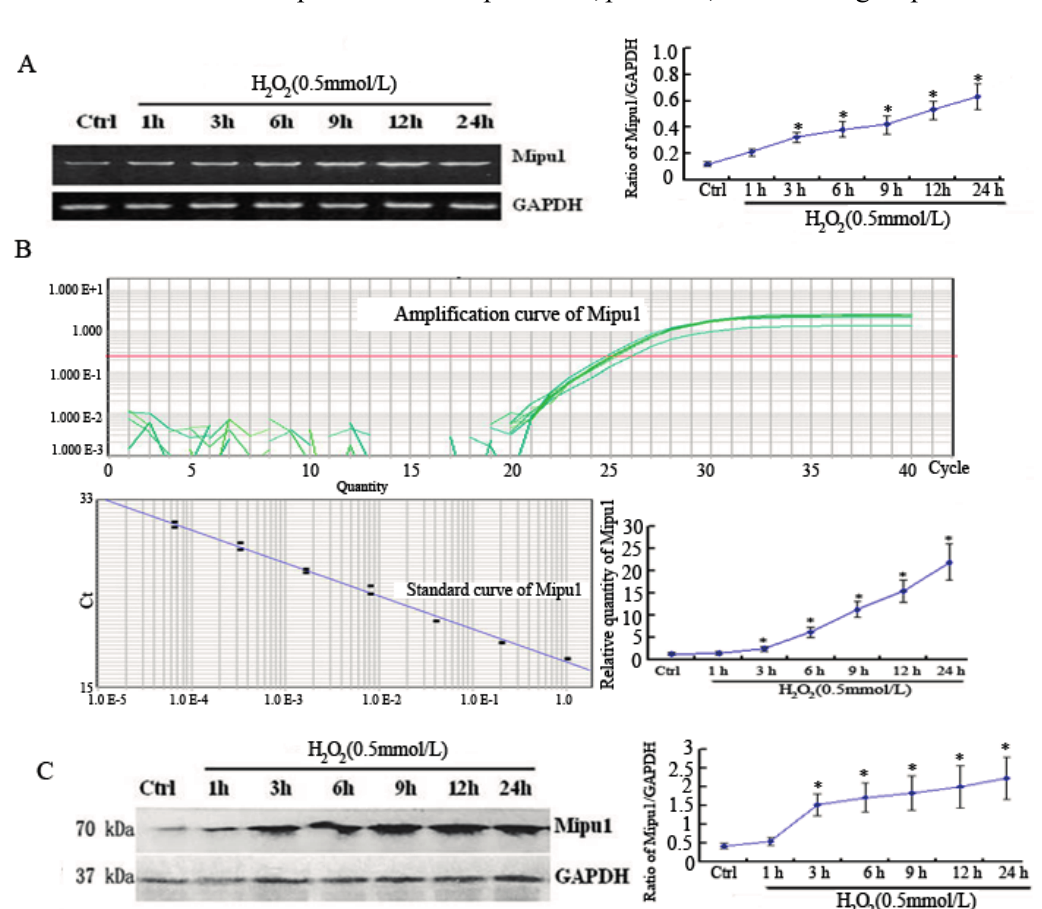
Figure 1. Expression of Mipu1 over H 2 O 2 -stimulated H9c2 myogenic cells over 24 h. ( A ) mRNA levels of Mipu1 over various periods of time were determined by